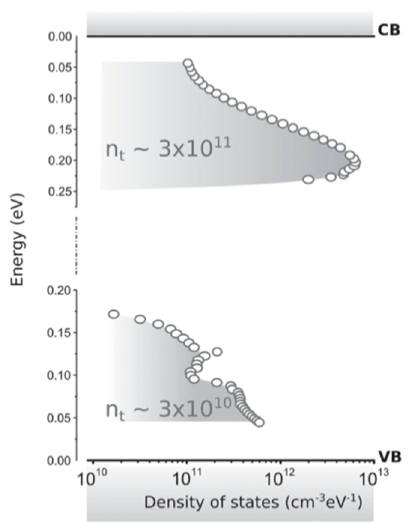
Figure 5. Density of the trap states (with their energetic distribution) within the band gap, extracted from the temperature-dependent properties. The valence band has less traps, with a slightly smaller energy distribution. Reproduced with permission from Adv. Mater. 2016 , 28 , 3406–3410. Reference [12].